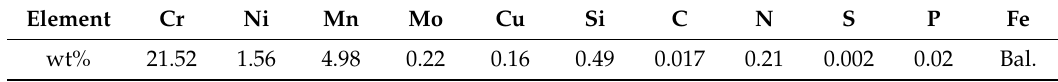
Table 1. Chemical composition of the base metal (BM) (wt.%).